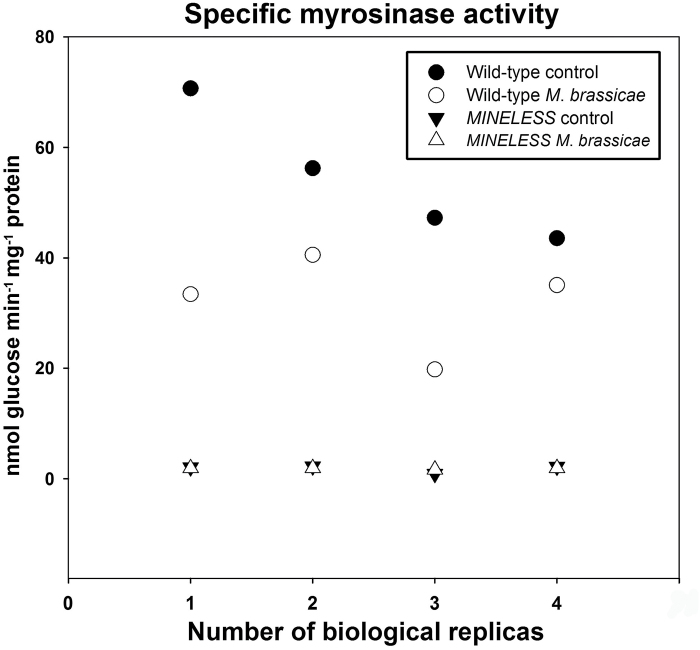
Myrosinase activity in control and M. brassicae-challenged seedlings (n = 4). No pairwise significant differences were found after post hoc Bonferroni corrections (P < 0.00833), but a P value of 0.02857 was observed for all pairwise comparisons except MINELESS control vs MINELESS M. brassicae.